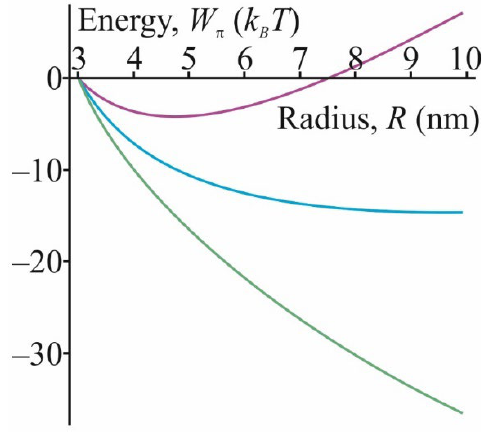
Figure 8. The dependence of the energy of π -shaped structure W π on its radius R for different values of the spontaneous curvature J s = − 0.1 nm –1 (purple color), J s = − 0.15 nm –1 (cyan color) and J s = − 0.2 nm –1 (green color).